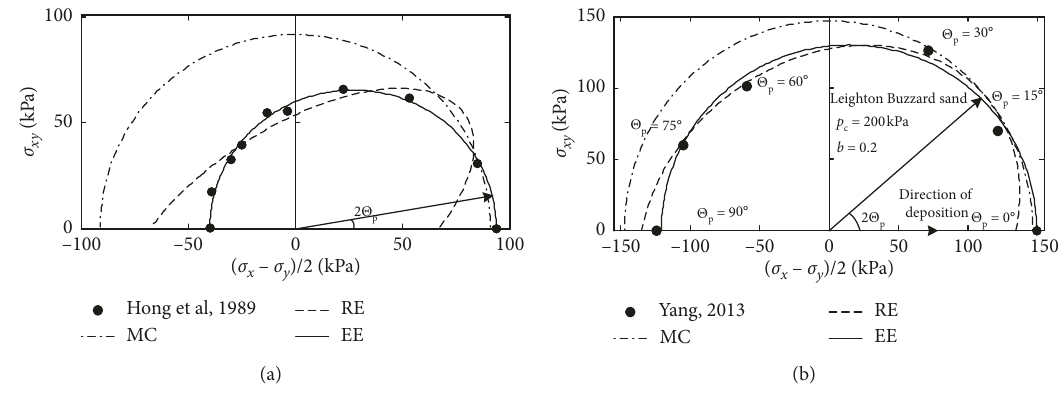
Figure 1: Validation of the anisotropic yield criterion (after